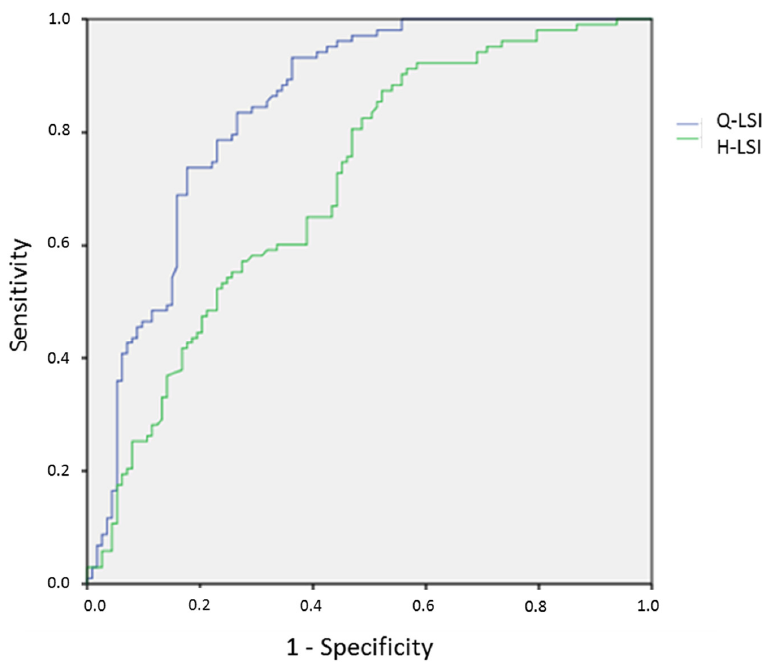
Figure 2. Receiver operating characteristic (ROC) curve area to return to running with Q-LSI and H-LSI. Abbreviations: Q: quadriceps; H: hamstring; LSI: Limb Symmetry Index. Table 5. ROC curve area, cut-off, sensitivity, specificity, and likelihood ratio for predictive parameters. ROC Curve Area [95%CI] Cut-Off [95%CI] Se Sp Lysholm Score 0.691 [0.621–0.762]